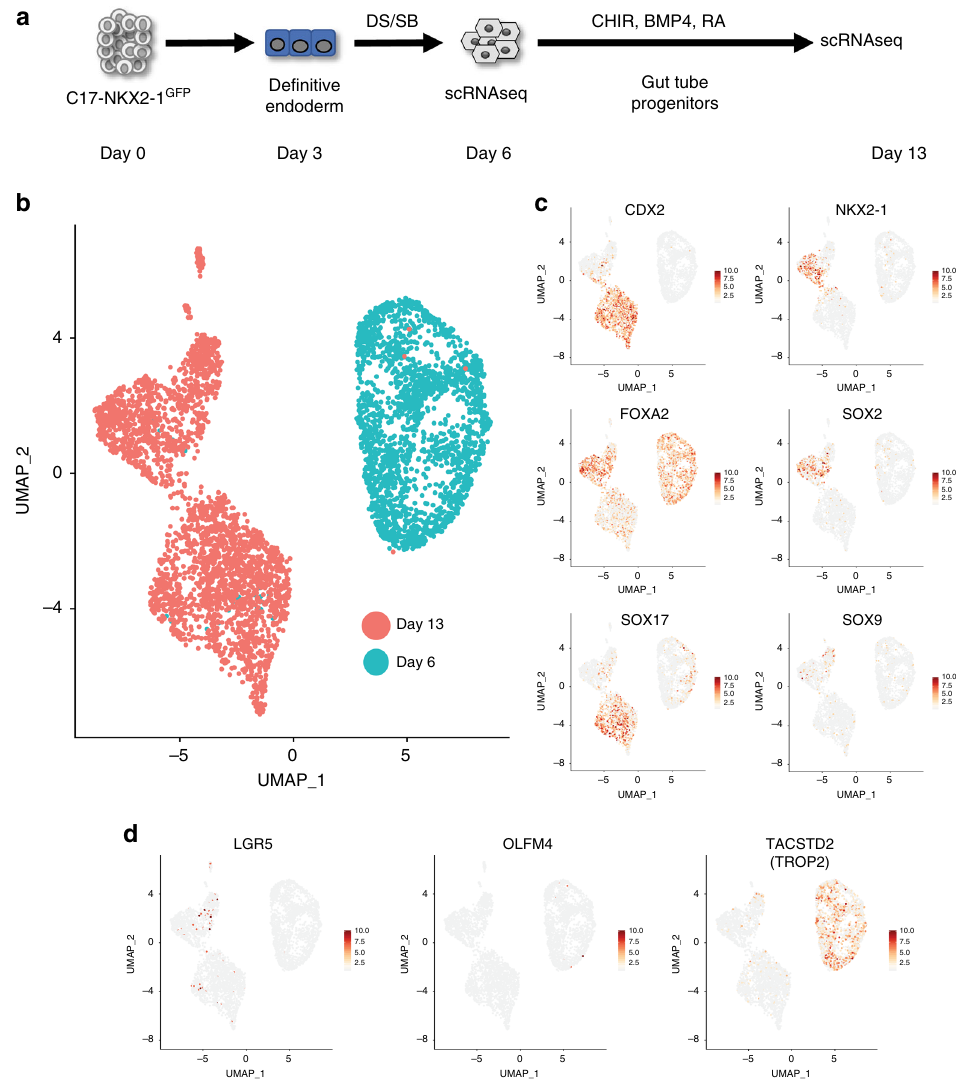
Fig. 2 scRNAseq of day 6 and day 13 progenitors. a Experimental schematic of scRNAseq, performed at day 6 (following 3 days of dual-smad inhibition) and day 13 (following 7 days of speci fi cation in CBRa). b UMAP visualization of cells at days 6 and 13 of differentiation. c UMAP visualization of expression of speci fi c endodermal ( SOX17 and FOXA2 ), lung ( NKX2-1 , SOX2 , and SOX9 ) and intestinal (CDX2) markers at days 6 and 13 of differentiation. Color scale indicates normalized log fold change of gene expression. d UMAP visualization of expression of intestinal stem cell markers LGR5 , OLFM4 , and TACTSTD2 (TROP2) in cells at days 6 and 13 of